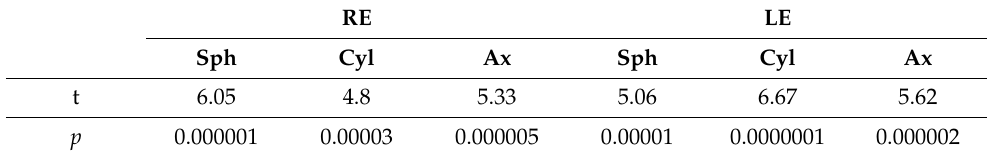
Table 4. Student’s t -test. RE = right eye; LE = left eye; Sph = sphere; Cyl = cylinder; Ax = axis.